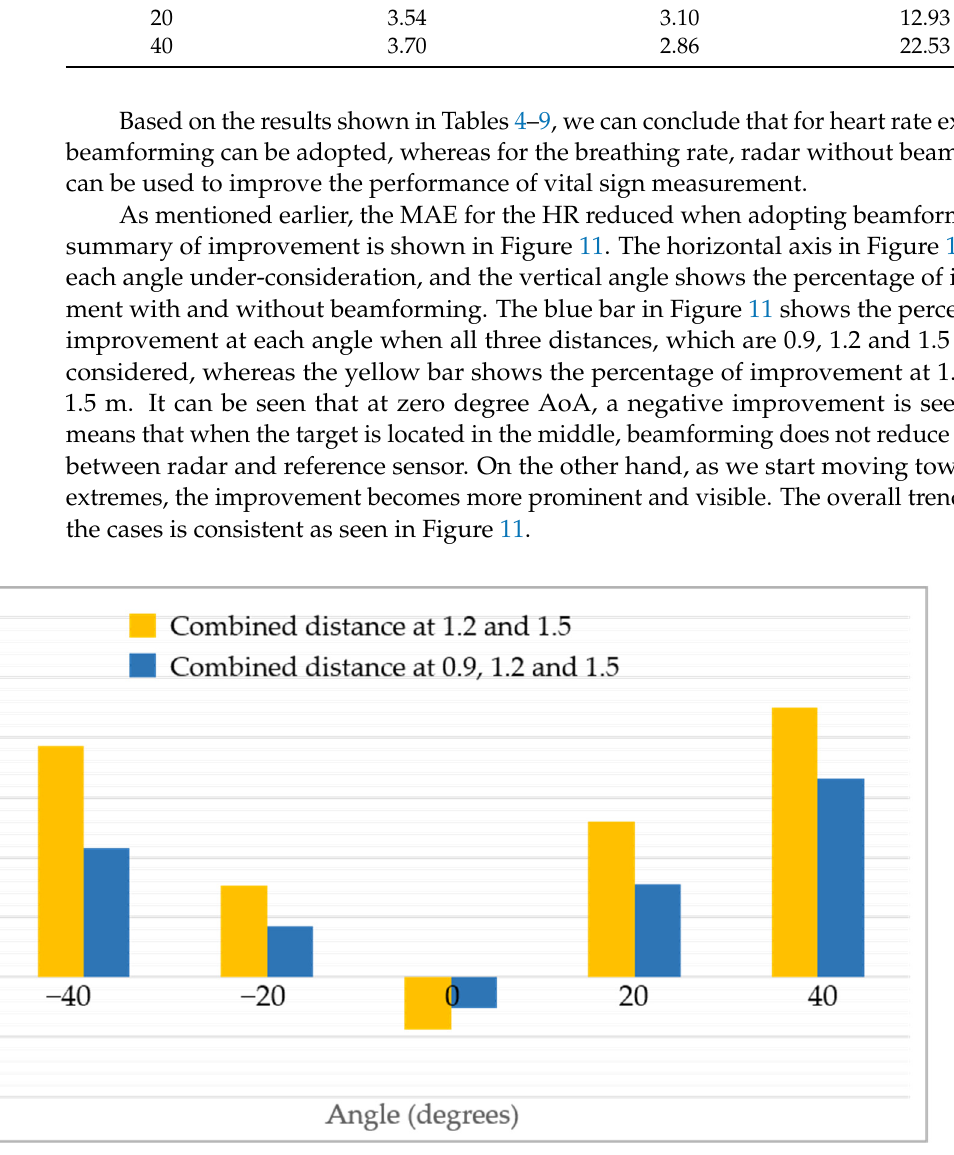
Figure 11. Improvement quantification of heart rate extraction when beamforming was applied.